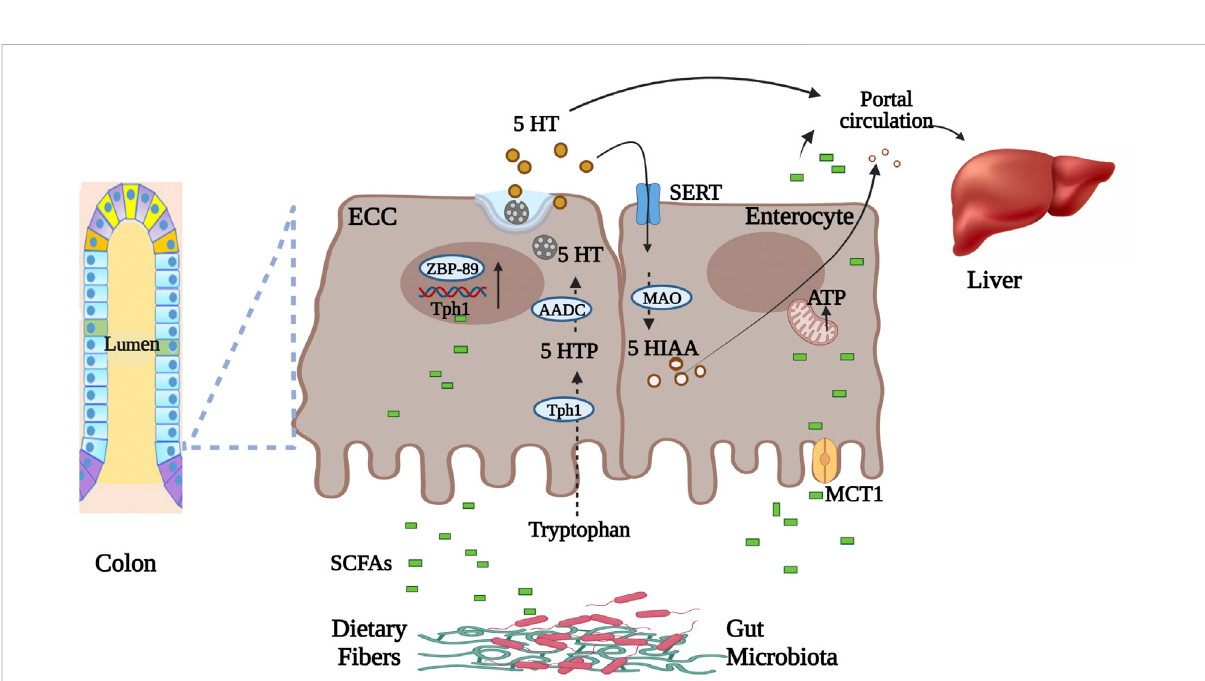
FIGURE 1 Microbial metabolite SCFAs transportation and role in gut serotonin production. Undissociated form of SCFAs in gut lumen diffuse through enterocytes while dissociated is transported through MCT1 into the circulation. Intestinal enterochromaf fi n cells synthesize serotonin from tryptophanusingTph1enzyme.SCFAsingutlumenstimulateTph1expressionviazinc fi ngertranscriptionfactor.Secretedserotonin,beforeentering circulation, is either utilized in the liver or metabolized by enterocytes to 5-HIAA. Part of luminal SCFAs is utilized for energy production